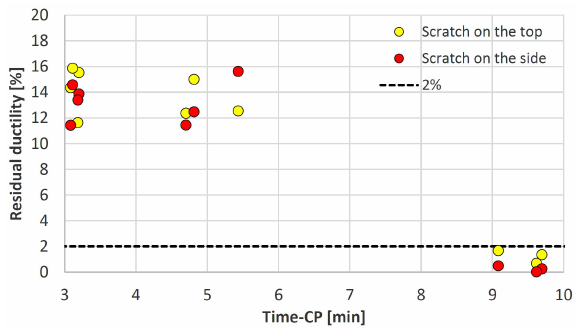
Figure 12. Comparison of single- and double-sided oxidation.